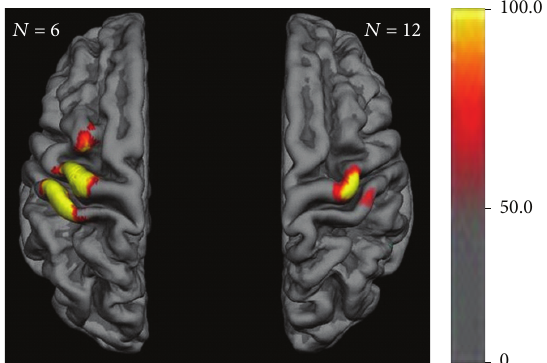
Figure 4: Motor map group data of individual means over time with mean MEP amplitude. Color bar indicates mean MEP amplitude in 𝜇 V throughout the experimental sessions.